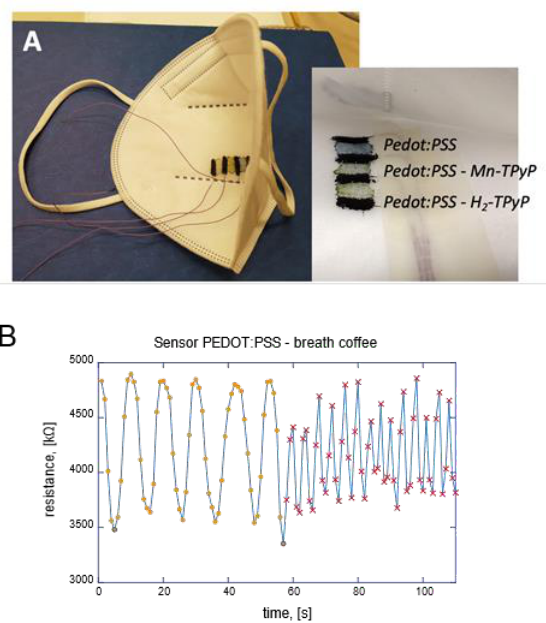
Figure 7. ( A ) Detail of the sensors deposited on the internal surface of the face mask. ( B ) Signal of PEDOT:PSS sensor taken after coffee ingestion. The measurement consists of two sequences of respirations at slow and normal rates (about 6 and 14 breaths per minute).